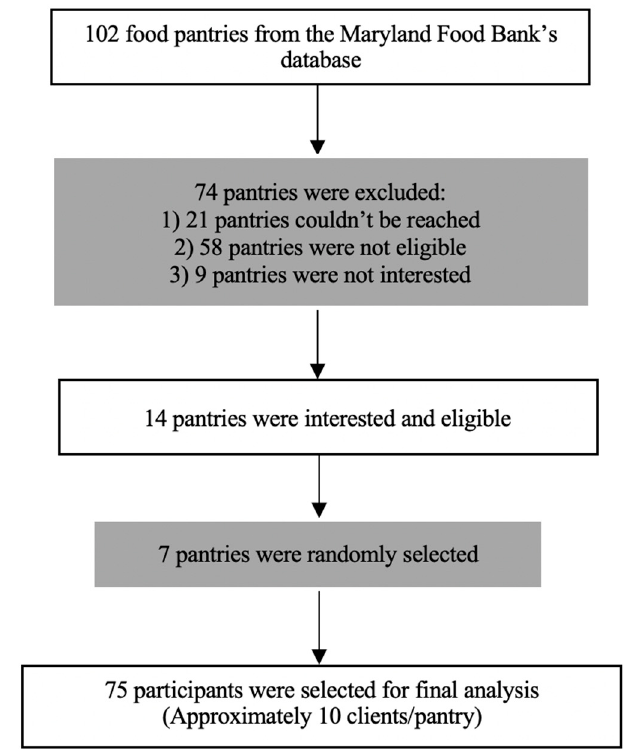
Figure 1. Flow chart of participants in this study.